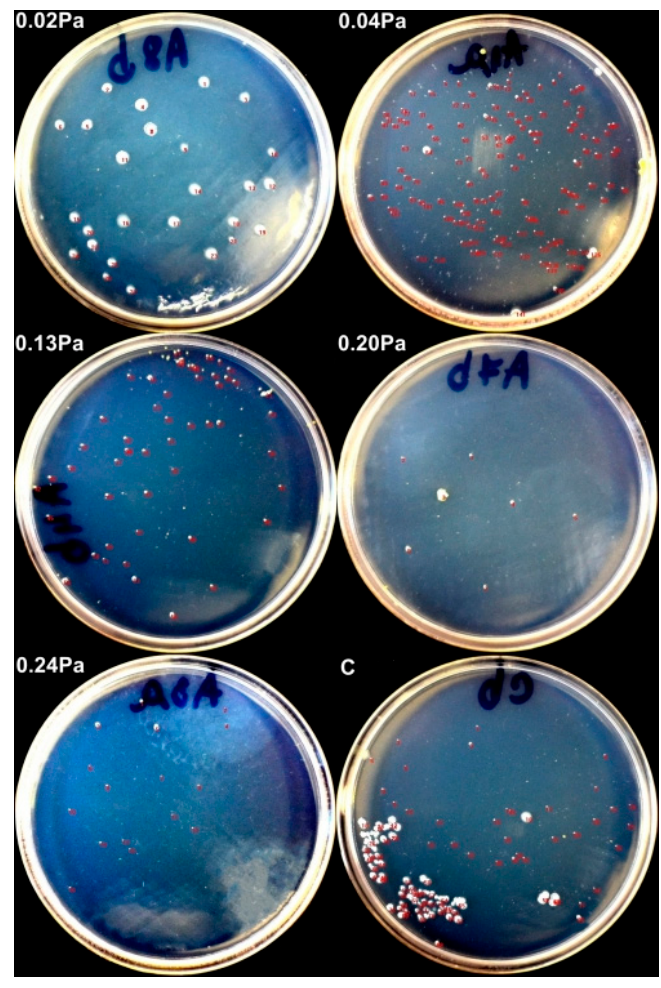
Figure 15. Bacterial colonies grown on agar plates.